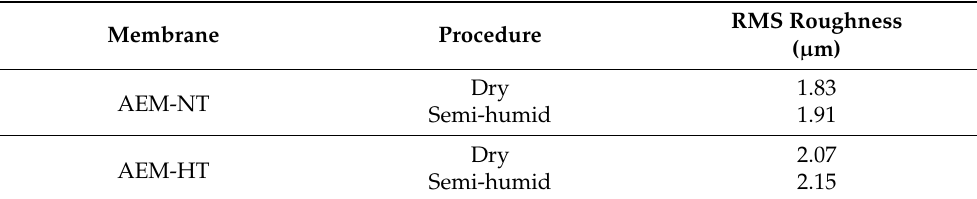
Figure 4. Atomic force microscopy (AFM) images for the electrospun AEMs. ( A ) dry AEM-NT, ( B ) dry AEM-HT, ( C ) semi-humid AEM-NT and ( D ) semi-humid AEM-HT. Table 5. Root mean square (RMS) roughness values for the electrospun AEM-NT and AEM-HT membranes.